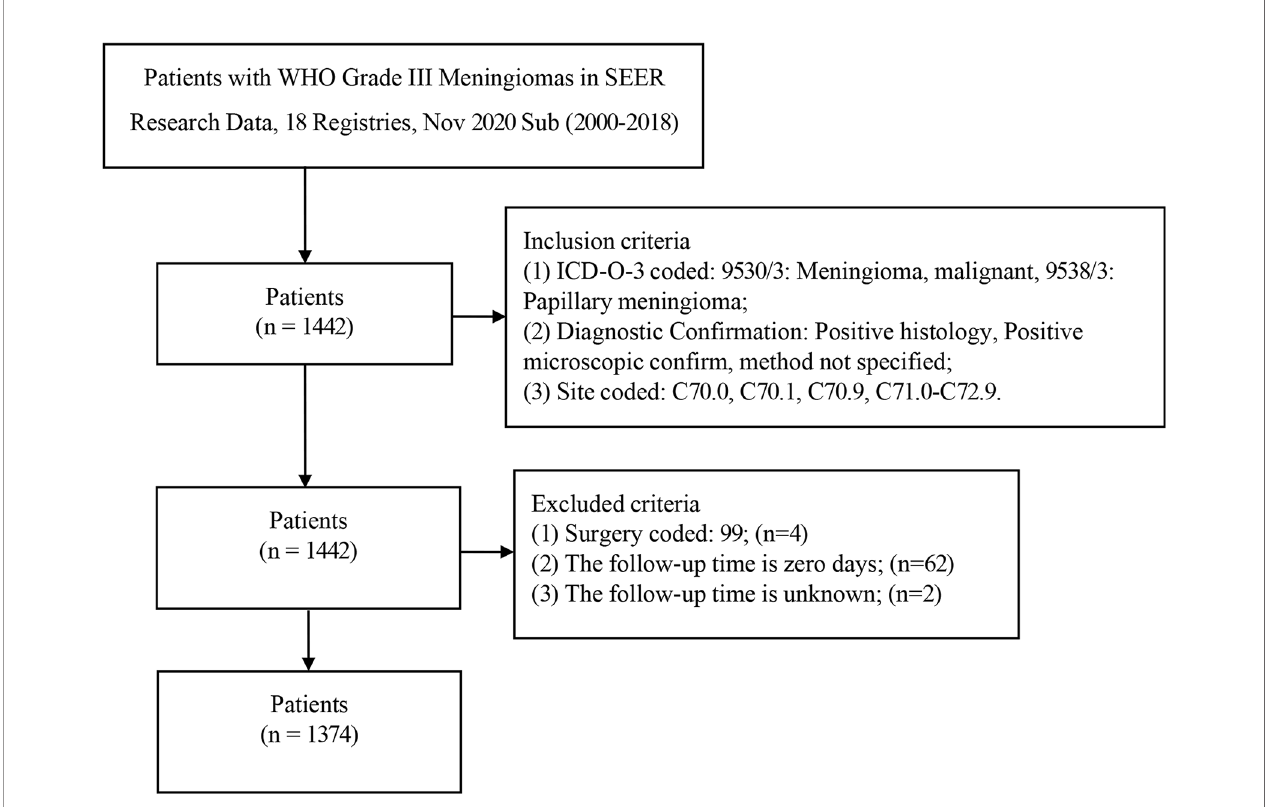
FIGURE 1 | Flowchart of participant inclusion and